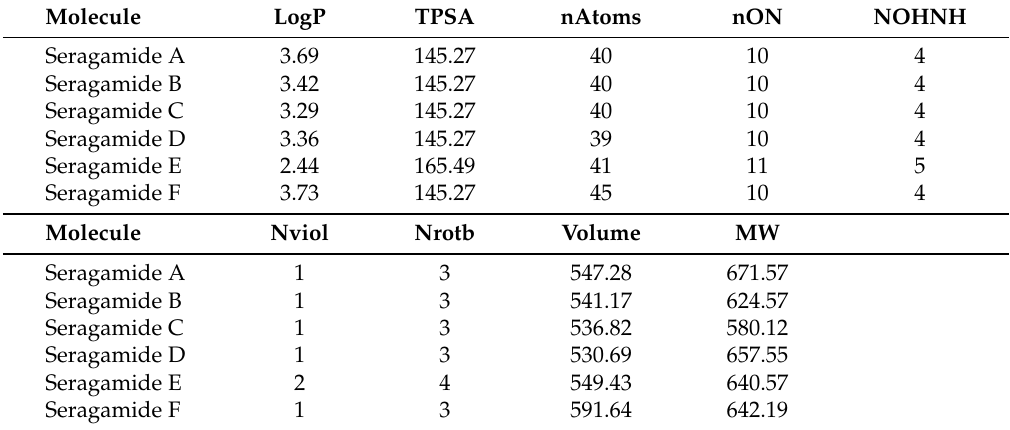
Table 4. Molecular properties of Seragamides A–F calculated to verify the Lipinski Rule of Five.